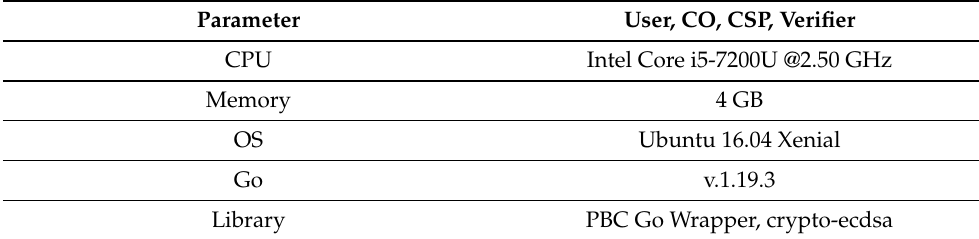
Table 1. Development environment of the user, CO, CSP, and